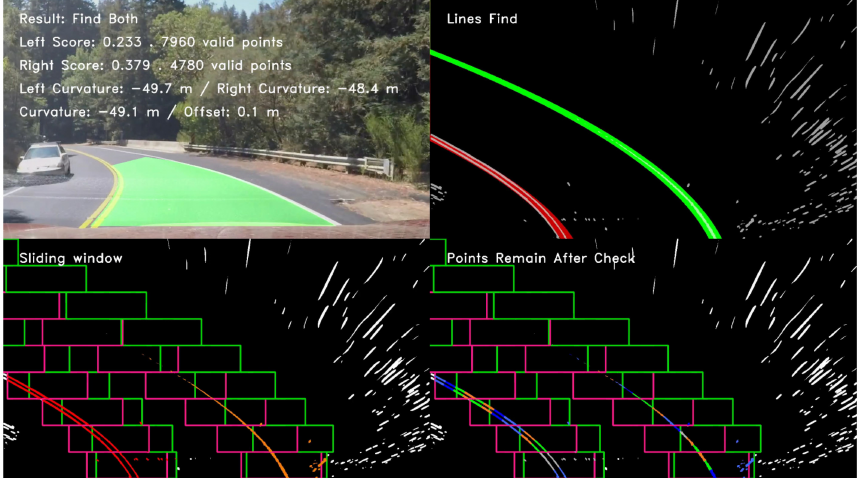
Figure 14. The test result of a typical detected frame in the mountain road driving